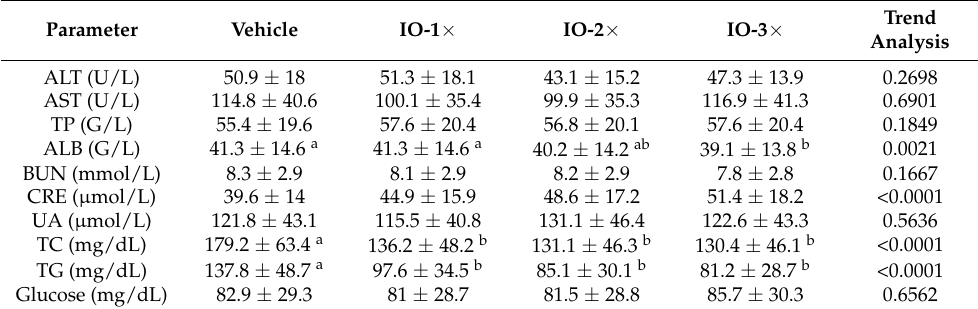
Table 2. Effect of 6-week IO supplementation on biochemical variables.